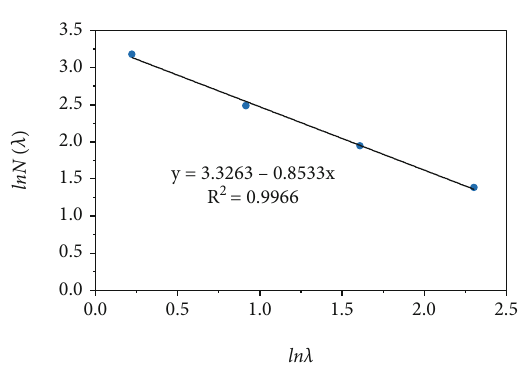
Figure 8: Calculation of fracture fractal dimension.